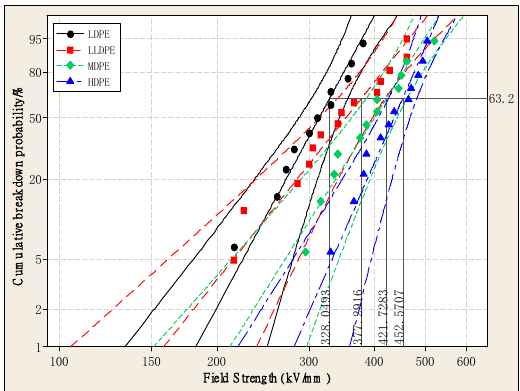
Figure 4. Weibull plots of the DC breakdown strength of four kinds of polyethylene. Table 2. Parameter and breakdown strength of polyethylene.